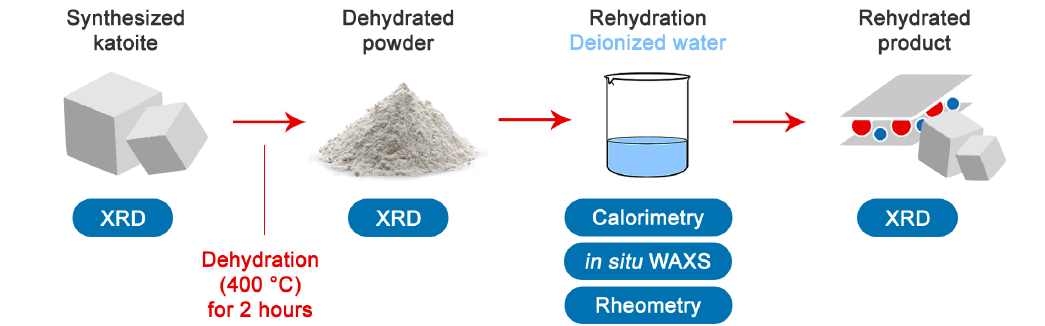
Figure 1. Methodology of the